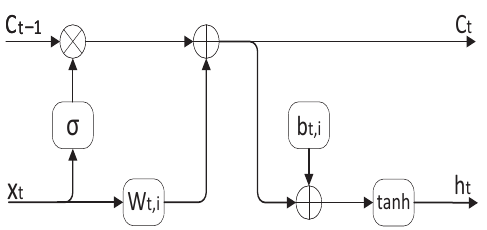
Figure 3. Schematic diagram of an improved LSTMs